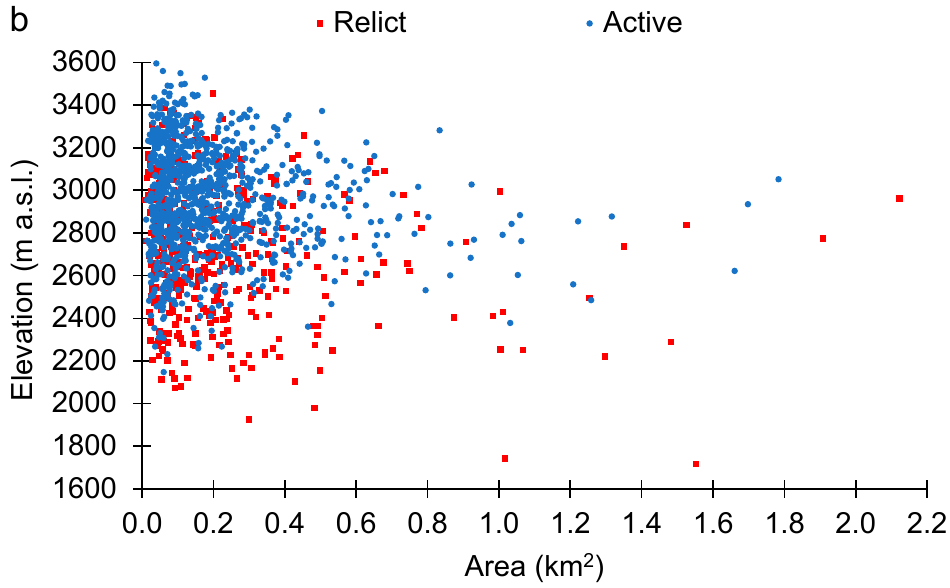
Figure 5. ( a )—Individual rock glacier area versus maximum and minimum elevation for the entire Greater Caucasus. ( b )—Individual rock glacier area versus minimum elevation (snout position) of relict and active rock glaciers for the entire Greater Caucasus.